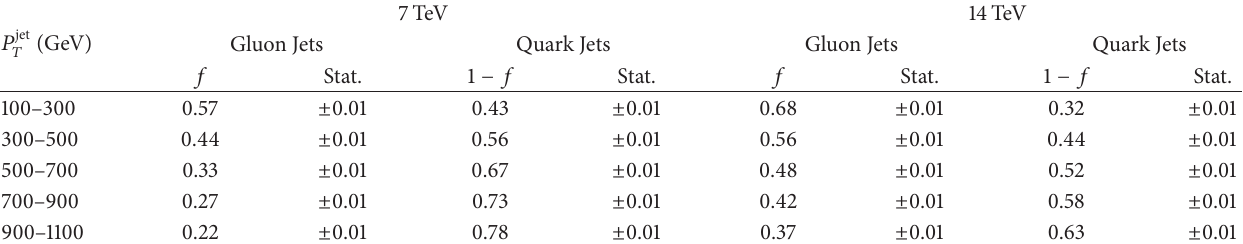
Table 4: Fraction of gluon and quark jets in phase space |𝜂| < 2 in different 𝑃 jet 𝑇 (GeV) bins for 𝑘 𝑇 algorithm. 𝑃 jet 𝑇 (GeV)